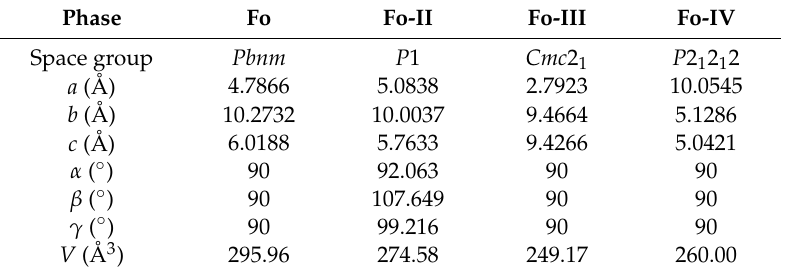
Table 2. Space groups and optimized unit-cell parameters of Fo, Fo-II, Fo-III and Fo-IV at 0 GPa (0